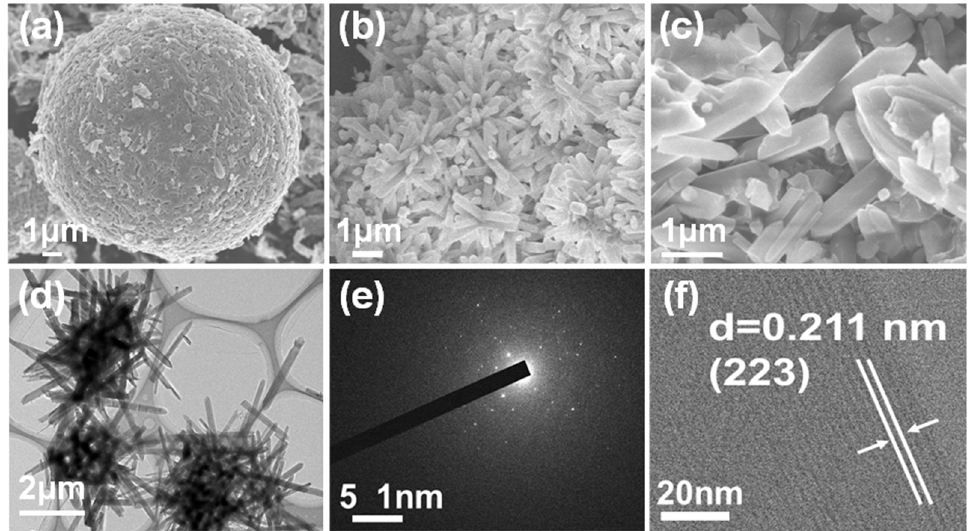
Figure 2. ( a ) SEM image of NiOOH. ( b,c ) SEM image of MOF-74(Ni)/NiOOH. ( d ) TEM image of MOF-74(Ni)/NiOOH, ( e ) SEAD pattern of MOF-74Ni/NiOOH. ( f ) HRTEM image of MOF-74Ni/NiOOH. Moreover, to understand the electronic interaction and the electronic state and chem- ical composition, the elements of Ni 2p and O 1s of NiOOH, MOF-74(Ni) and